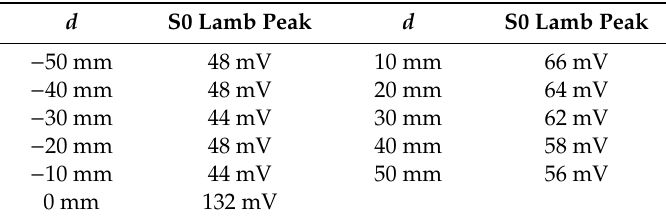
Figure 7. The ultrasonic waves received by EMAT in scanning inspection. Table 2. The relationship between d and the peak-to-peak value of the S0 Lamb